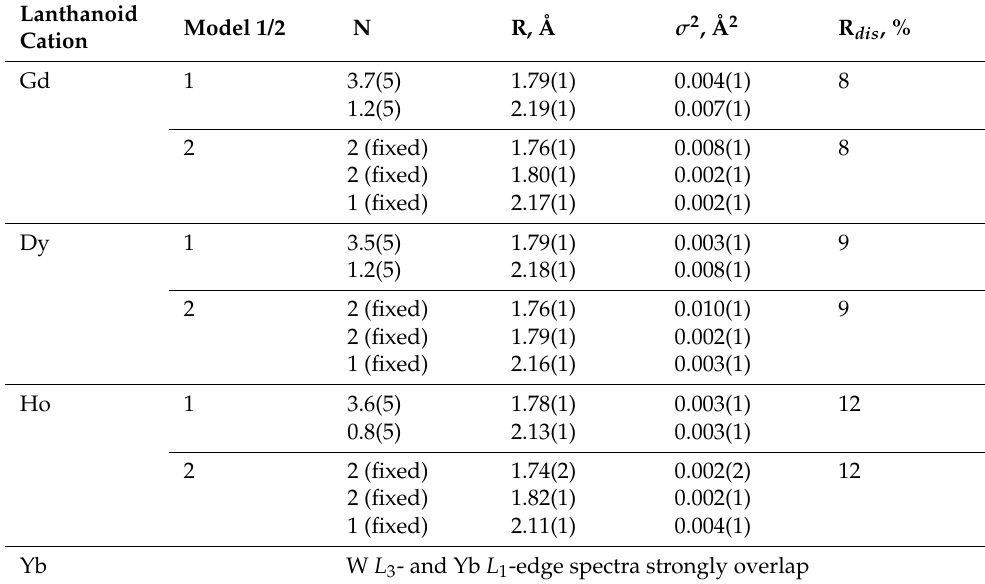
Table 3. W L 3 -edge EXAFS best-fit results for the W-O coordination shells for hydrated well- crystallized Ln WO-1000-1.5y ( Ln = Gd, Dy, Ho, Yb )